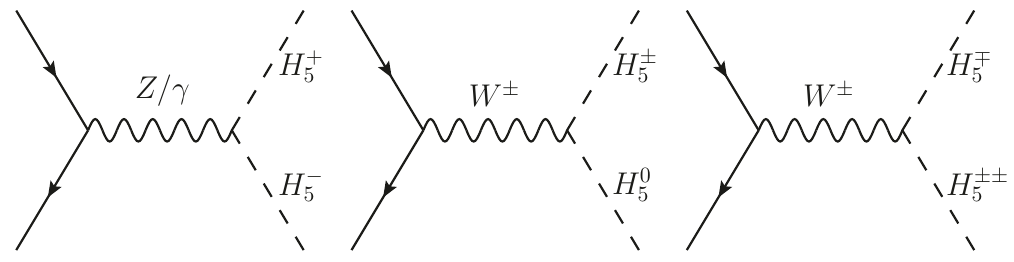
Figure 4 . Feynman diagrams for the dominant Drell-Yan production processes involving H (cid:6) s H m 5 . 1 and m 3 (cid:28) (cid:29)